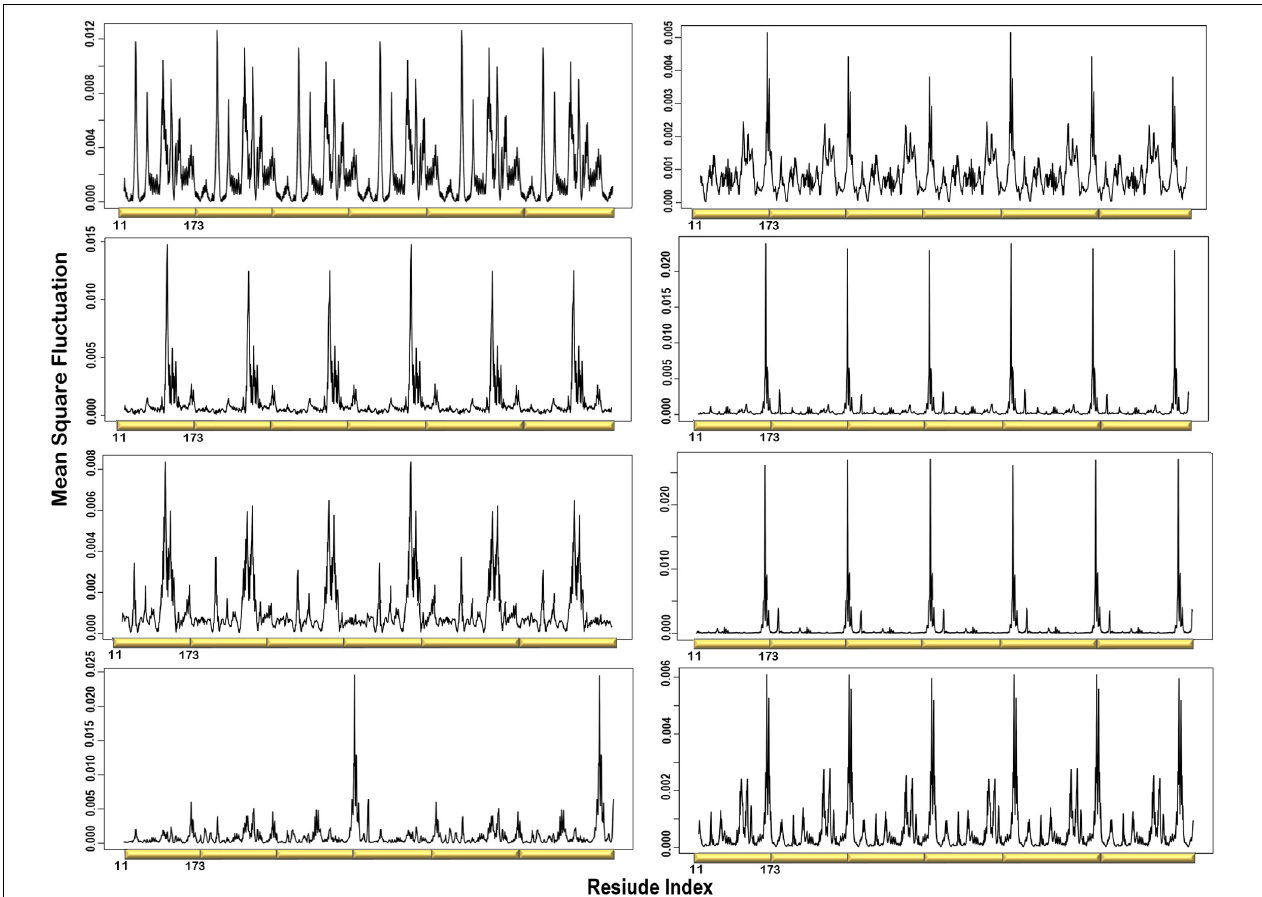
FIGURE 3 | Individual MSF profiles of the eight non-degenerate modes. The yellow blocks represent each chain of the protein structure. The residues index is labeled for one chain along the lower abscissa and according to the P. falciparum (PDB ID: 1Y13)